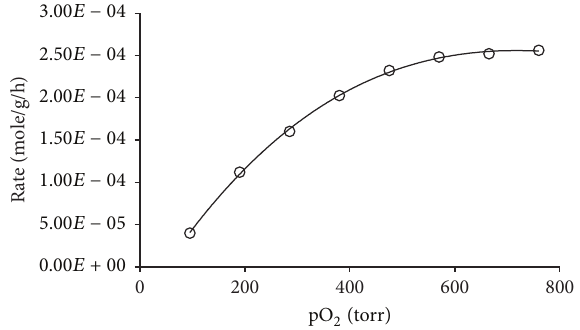
Figure 9: Effect of partial pressure of oxygen on oxidation of cyclohexanol. Reaction conditions : Cat, 0.1 g; time, 6hrs; temp.,